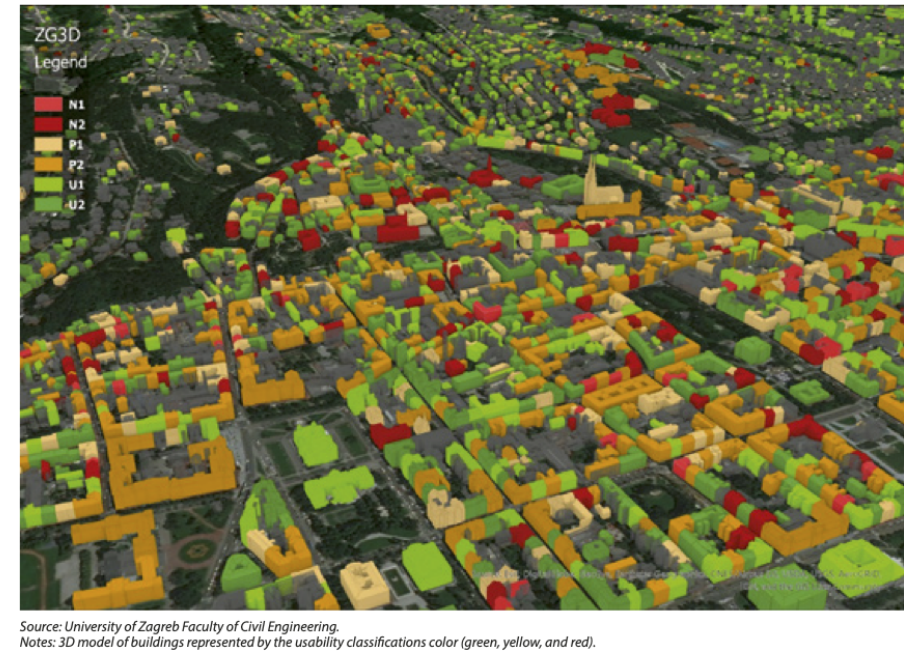
Figure 5. Building damage grades in the city of Zagreb following the 2020 March earthquake.